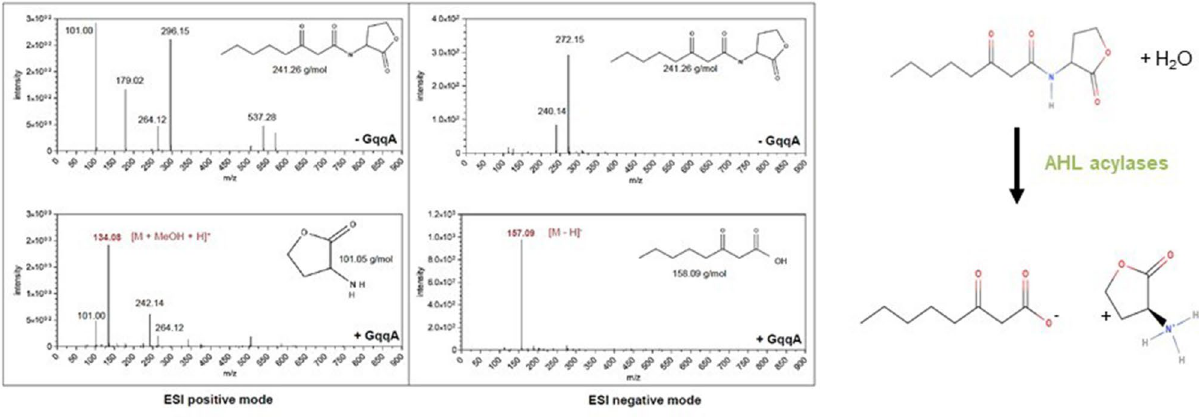
Figure 3. ESI/MS measurements of GqqA on 3oxo-octanoyl homoserine lactone. The upper spectra indicate the control without enzyme (-GqqA) in the positive (left) and in the negative (right) mode. MeOH was used as solvent during MS analysis, it appears an esterified substrate or product. The control spectrum in the positive mode shows an [M + MeOH + Na]+ ion at an m/z of 264.14 and an [2 M + 2MeOH + Na]+ ion at m/z of 537.28 that indicate the substrate 3oxo-octanoyl homoserine lactone. The structural formula is drawn in the spectrum. The substrate is also observed at an m/z of 240.14 [M–H]—in the negative mode. By adding GqqA to the assay (lower spectra) the substrate is only observed in lower intensity. An [M + MeOH + H] + ion is observed at an m/z of 134.08 in the positive mode and indicates the product homoserine lactone. In the negative mode an [M–H]— ion is detectable at an m/z of 157.09 and displays the 3- oxo- octanoyl acid. The homoserine lactone and the 3-oxo- octanoyl acid are displayed in the spectra. The [M + Na] + ion at an m/z 101.00 and the [2 M + Na] + at an m/z at 179.02 display.